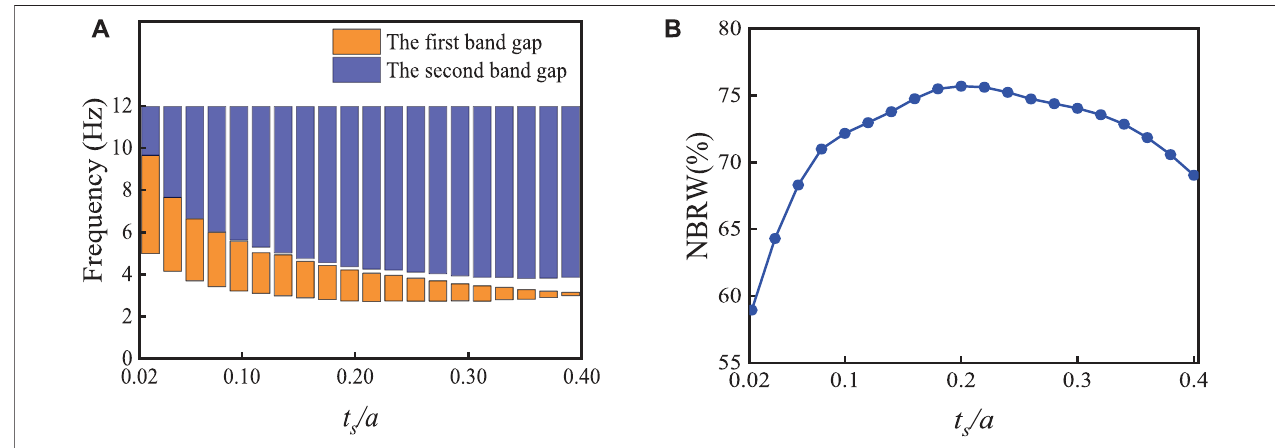
FIGURE6| Relationshipbetweenbandgapscharacteristicsandparameterratio t s /a : (A) theupperandlowerfrequencyboundsofbandgaps; (B) therelativeband width of bandgap (NRBW).